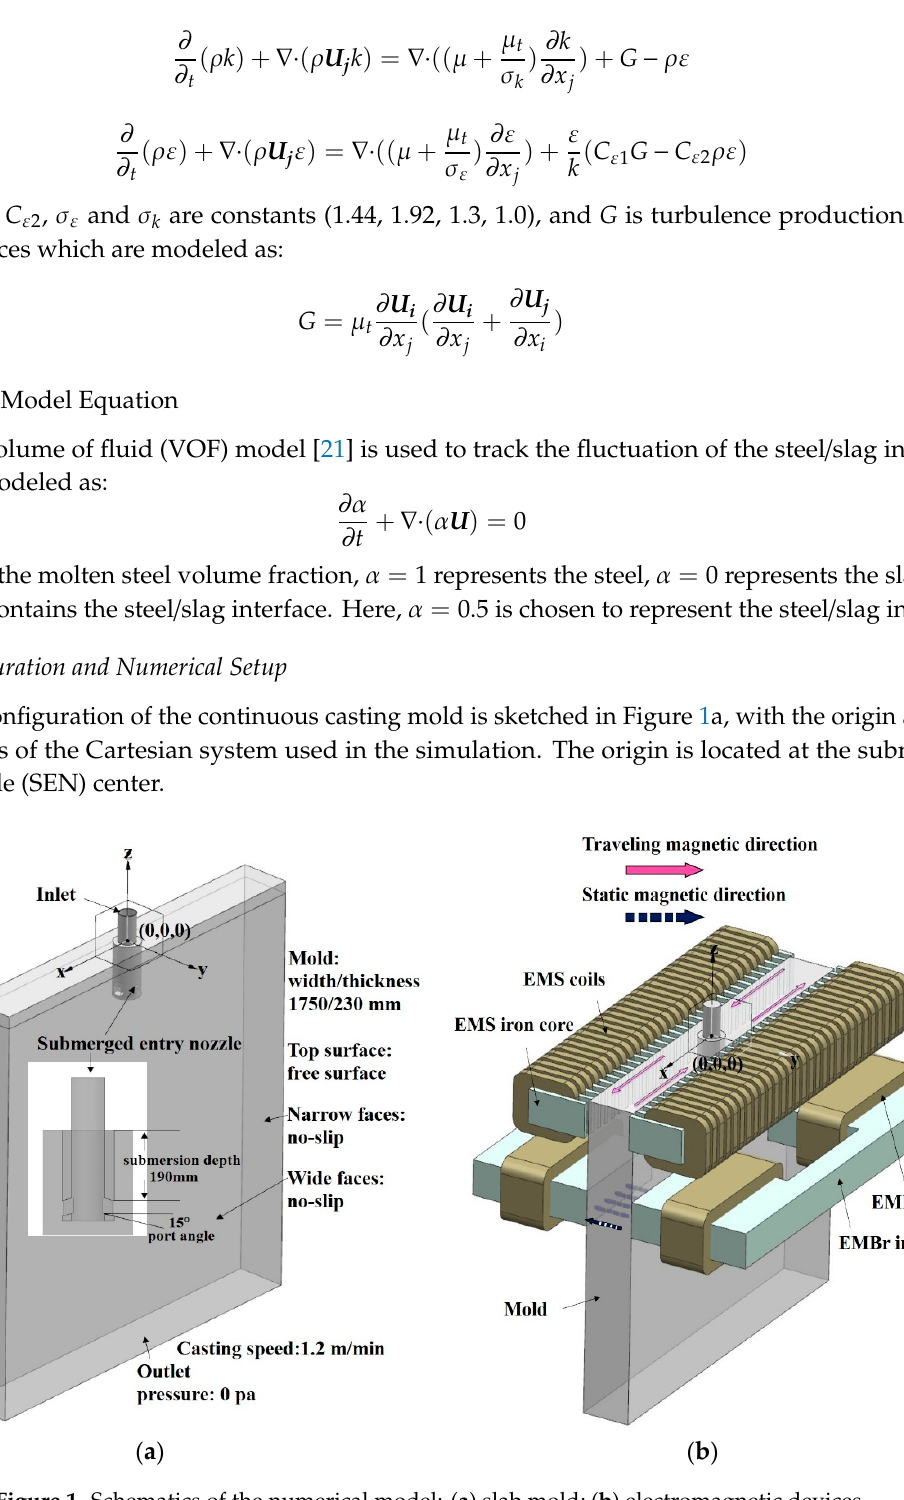
Figure 1. Schematics of the numerical model: ( a ) slab mold; ( b ) electromagnetic devices.